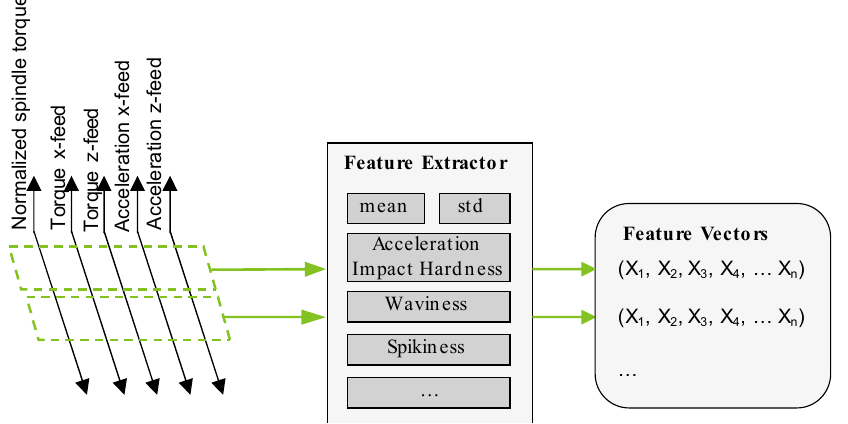
Figure 2. Procedure for extracting low-dimensional features from high-frequency control data.